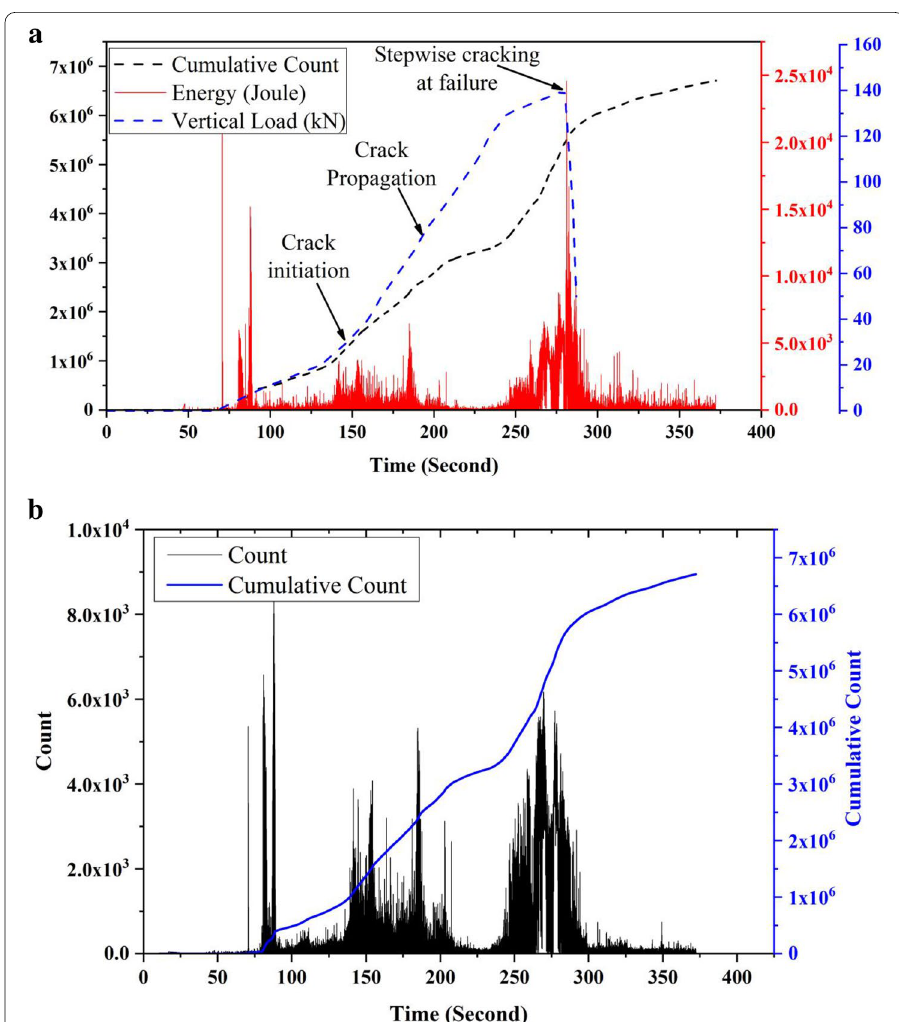
Fig. 7 Horizontally jointed model, a Plot showing the acoustic behavior and load vs time ( b ) Count and cumulative count vs